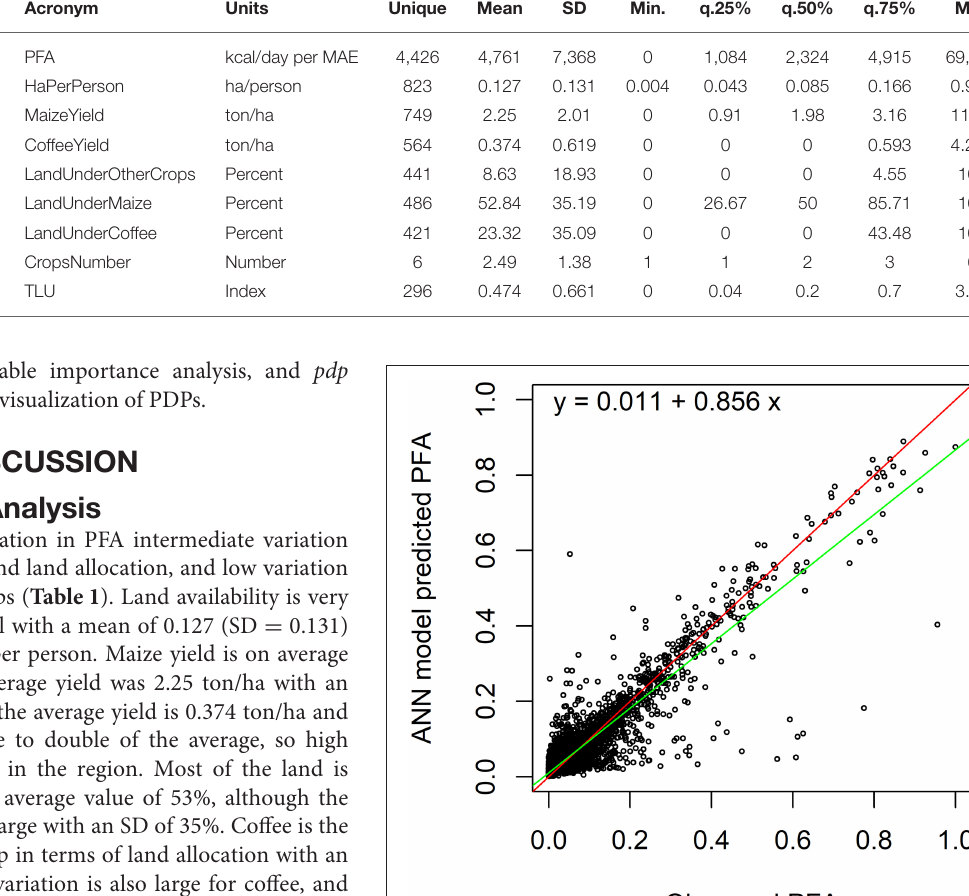
TABLE 1 | Descriptive statistics of the predictors and target variable. Variable